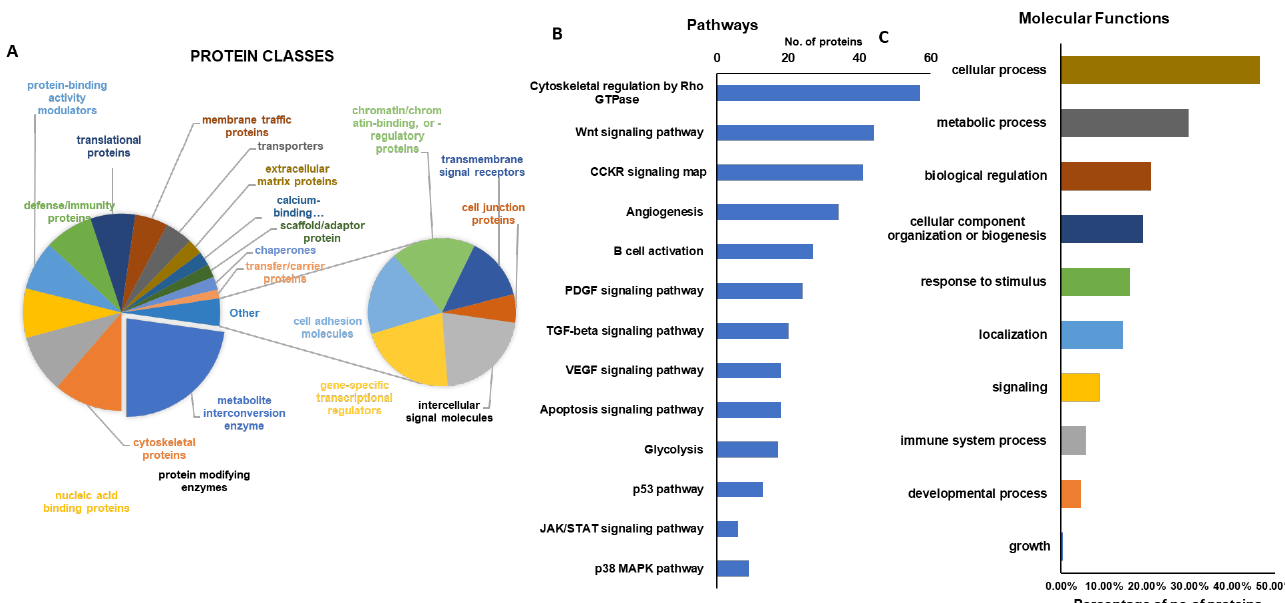
Figure 4. ( A .) Gene ontology analysis of identified proteins classifications, ( B .) Number of proteins from this study that are involved in various potential pathways, ( C .) Molecular functions of the identified proteins from the untreated and treated autografts.